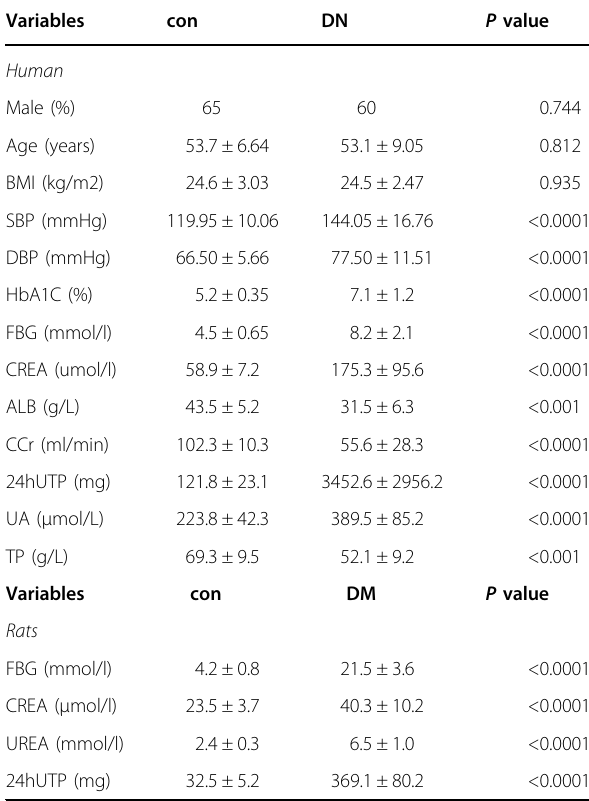
Table 1 Characteristics of participants and rats in the control (con) and diabetic nephropathy (DN)